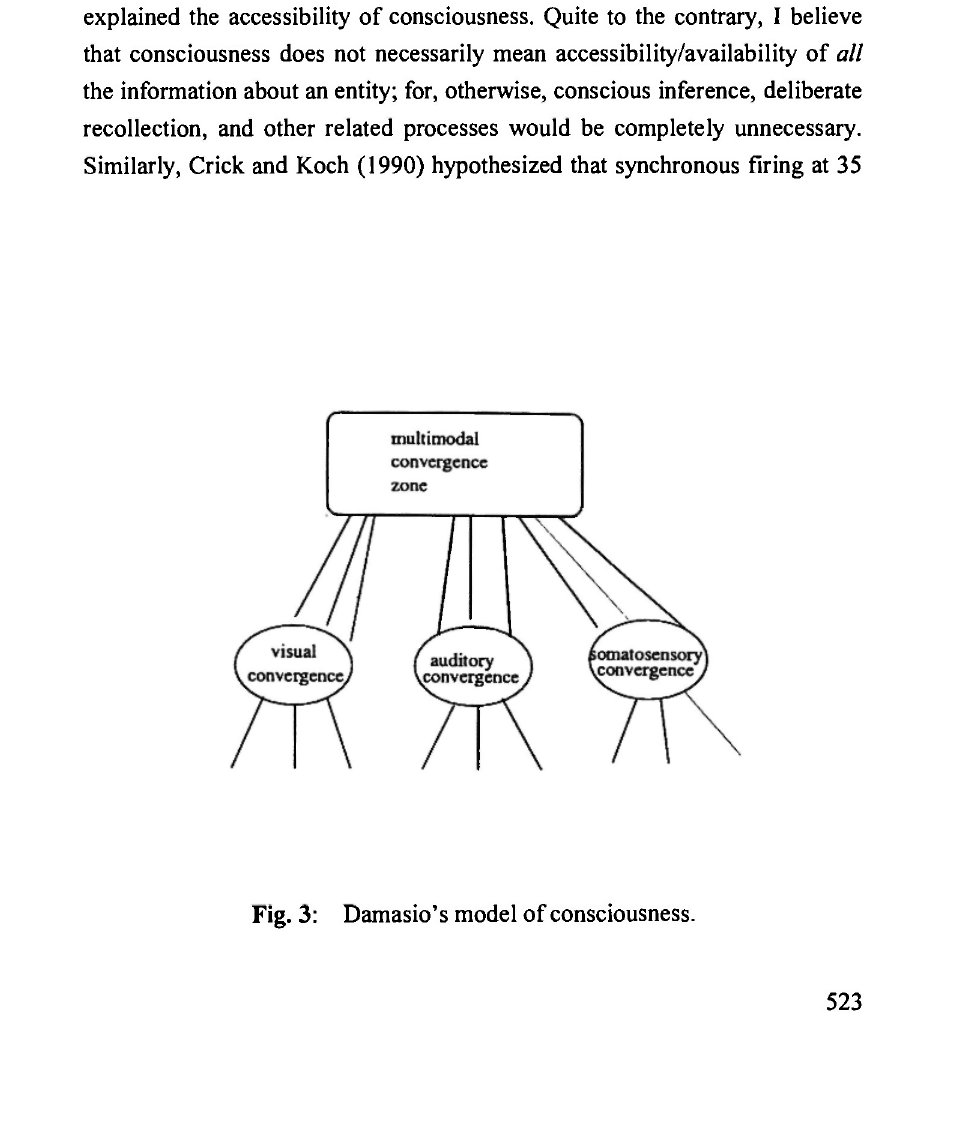
Damasio's model of